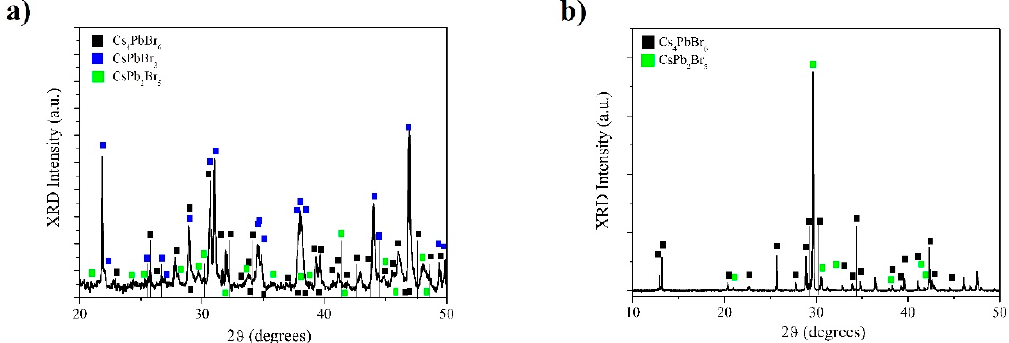
Figure 3. XRD spectra of perovskite: ( a ) unwashed powder; ( b ) powder washed with